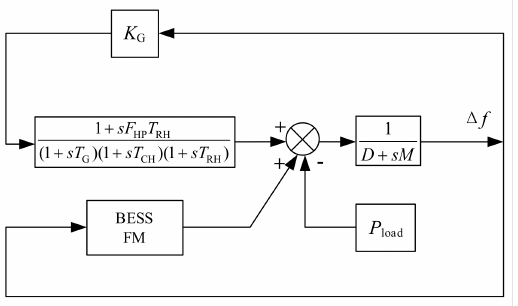
Figure 4. Schematic diagram of primary frequency modulation simulation model.